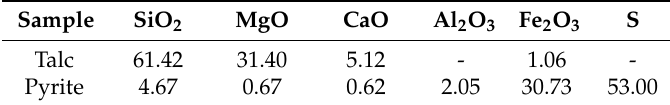
Table 1. Chemical composition of the purified samples (mass fraction,